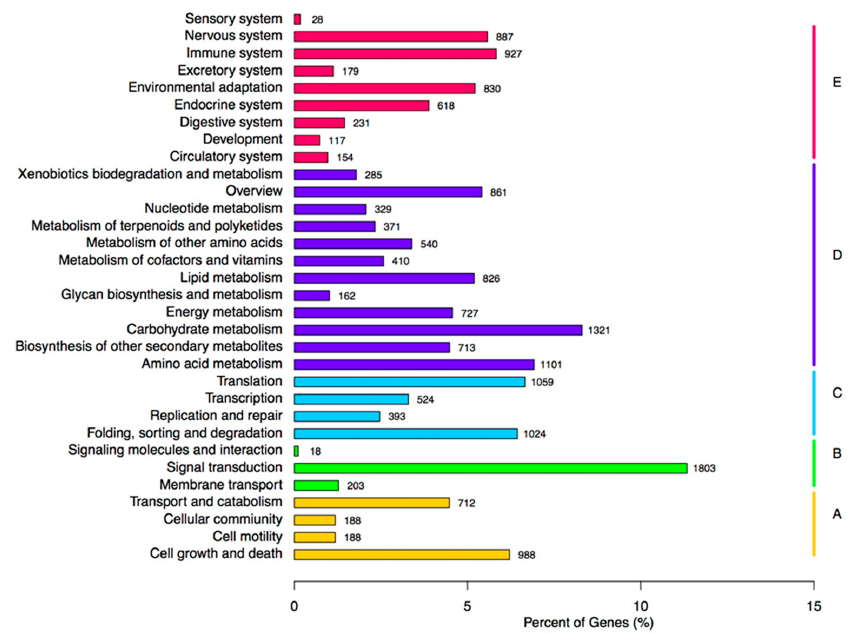
Figure 6. Pathway assignment based on KEGG. ( A ) Cellular Processes; ( B ) Environmental Information Processing; ( C ) Genetic Information Processing; ( D ) Metabolism; ( E ) Organismal Systems.